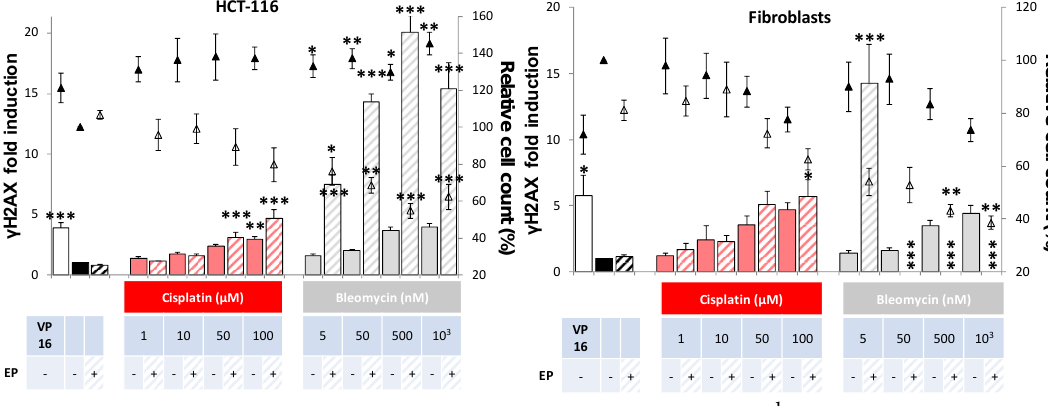
Figure 2. Cytotoxicity and genotoxicity of antitumor drugs bleomycin or cisplatin associated or not with electroporation in HCT-116 tumor cells ( a ) and normal dermal fibroblasts ( b ), 24 h after treatment. Cytotoxicity and genotoxicity of increasing concentrations of antitumor drugs cisplatin (red) and bleomycin (gray) associated or not with electroporation (EP). Induction of γH2AX (histogram) compared with control condition in pulsation buffer. Cytotoxicity associated (hollow triangles) or not (solid triangles) with electroporation is represented by the percentage of relative cell count compared with the control condition (no electroporation). VP16 indicates the positive control (incubation overnight with 3 µM of etoposide). Experiments were performed at least three times independently, in duplicate. Values represent the mean ± SEM. Statistically significant increases in H2AX phosphorylation and cytotoxicity after treatment were compared between each condition and its respective control (i.e., drug alone versus control; or drug associated with electric pulses versus EP) using one-way ANOVA followed by Tukey’s post-test. * p < 0.05; ** p < 0.01, *** p < 0.001.